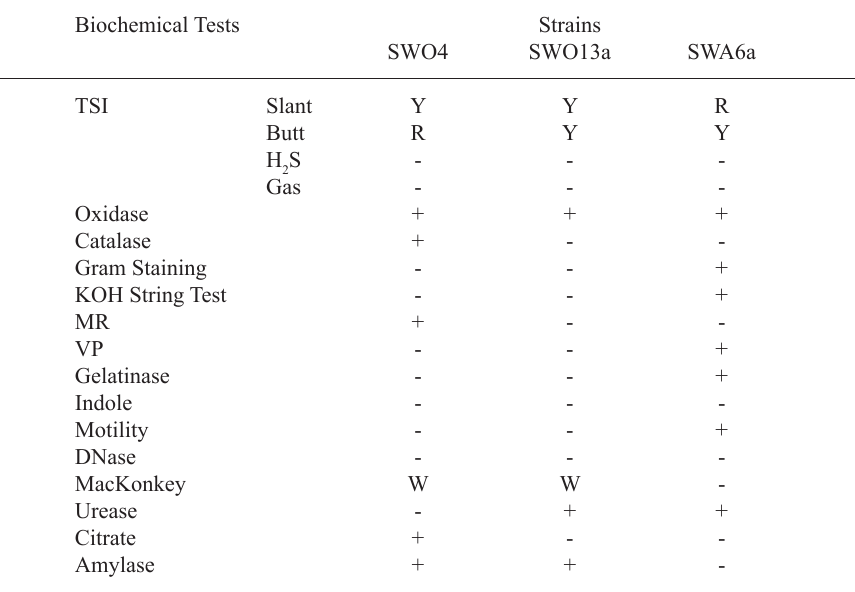
Table 1. Biochemical Tests Result of the Isolates. The Positive result is represented with + symbol and negative with – symbol. Y and R represents Yellow and Red colour of the indicator in TSI media. Yellow indicates that the strains are able to ferment sugars in aerobic (Slant) or anaerobic (Butt) condition whereas Red indicates negative result. W stands for white colony in MacKonkey media which indicates these strains were able to utilise lactose Biochemical Tests